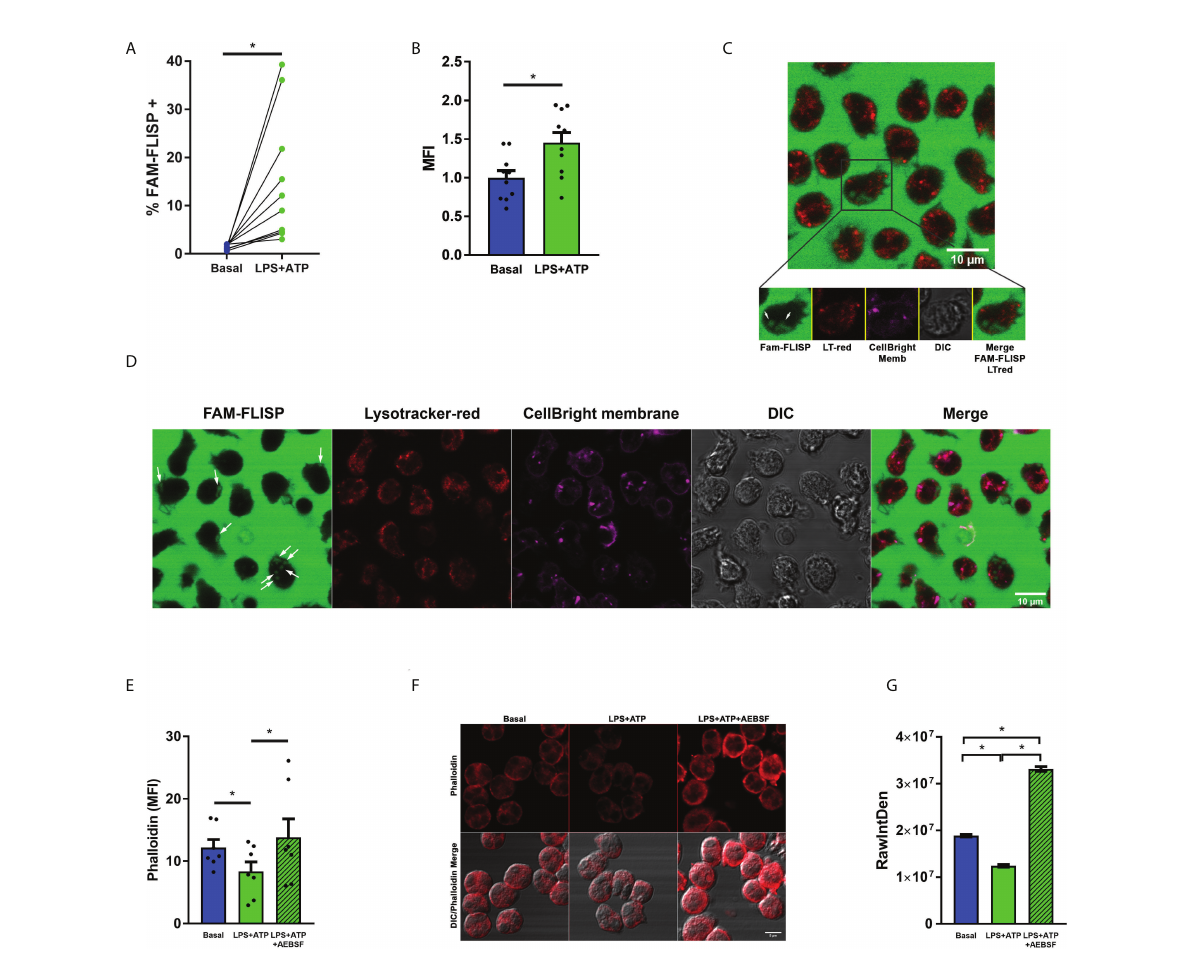
FIGURE 6 Neutrophil serine proteases undergo activation upon LPS+ATP stimulation. (A, B) Neutrophils from healthy donors were stimulated or not with LPS (t= 0), stained with the fl uorescent probe FAM-FLISP (t= 115 min), stimulated or not with ATP (t= 120 min) and fl uorescence was recorded by fl ow cytometry (t= 155 min). (A) Each point depicts the % of cells with FAM-FLISP positive signal. Results corresponding to each donor are linked with a line. (B) Mean ± SEM of the median fl uorescence intensity (MFI) values of FAM-FLICA signal. *p<0.05 One-tailed Paired t test. (C, D) Representative images acquired by time-lapse confocal microscopy of neutrophils stained with CellBrite fi x640 to delimit cell contour (magenta) and the fl uorescent probes FAM ‐ FLISP to detect active NSPs (green) and Lysotracker red (red). Cells were stimulated with LPS (1 m g/ ml in C or 150 pg/ml in D) and treated with ATP (2.5 mM; t= 2h). Images were acquired every 2 min (C) and 63 sec (D) . White arrows show the diffuse pattern of active NSPs. Images are representative of 3 (C) and 1 (D) experiments. Of note, the intense green fl uorescence outside the cells is emitted by the probe that had to be present during the whole experiment to increase the sensitivity of the assay. (E – G) Actin dynamic evaluated as a surrogate marker of NSP enzymatic activity in the cytosol. Neutrophils were pre-treated or not with AEBSF (0.35 mM), stimulated or not with LPS and 2 h later treated or not with ATP. Then, cells were fi xed, permeabilized and stained with TRITC-Phalloidin. Cell fl uorescence was evaluated by fl ow cytometry (E) and images were acquired by CLSM (F) and quantitated (G) . TRITC raw intensity density of the phalloidin signal was measured for each individual cell. (G) Graph depicts the mean ± SEM of raw intensity density values of 3 independent experiments in which at least 63 cells were analyzed. *p<0.05 One-way ANOVA (D) and Kruskal-Wallis test (F)